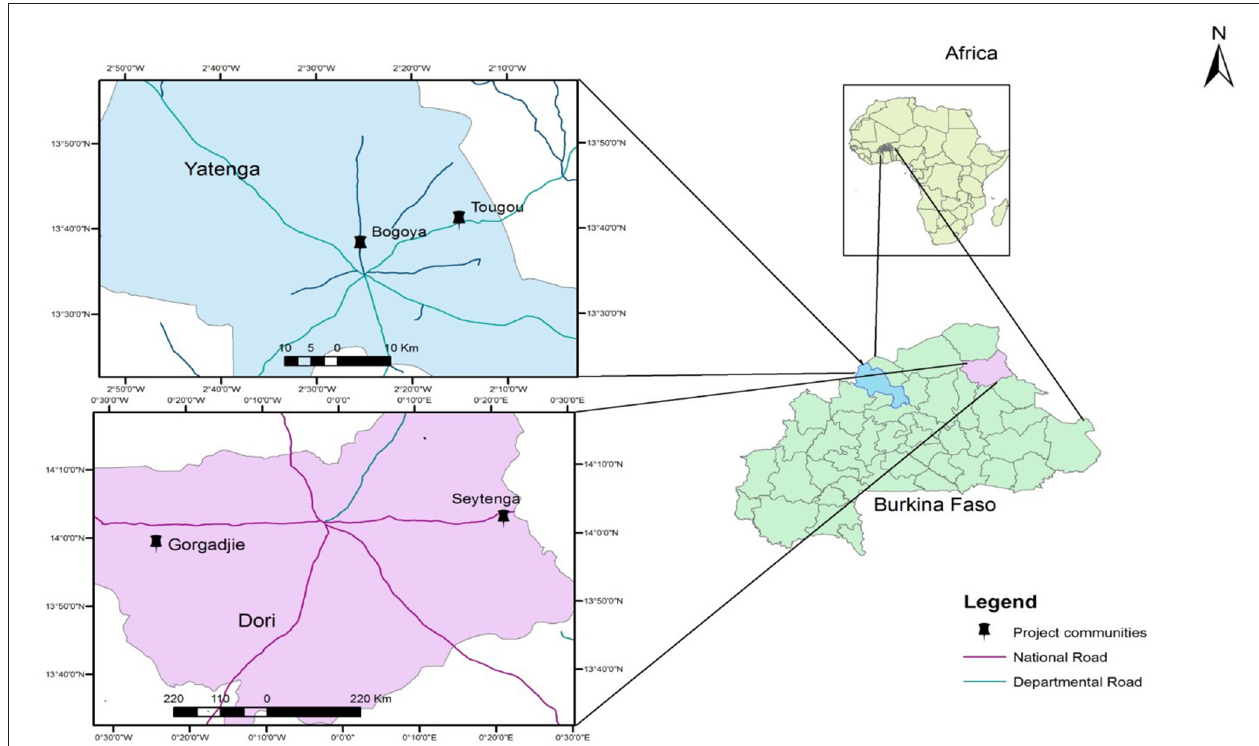
FIGURE 1 | The map of Yatenga and Seno province showing the study